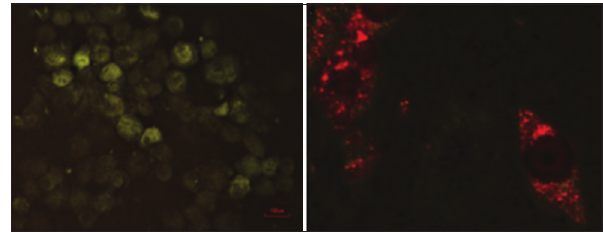
Figure-4: Percentage of canine distemper virus-positive adipose stem cells in isolates obtained from the dogs studied.